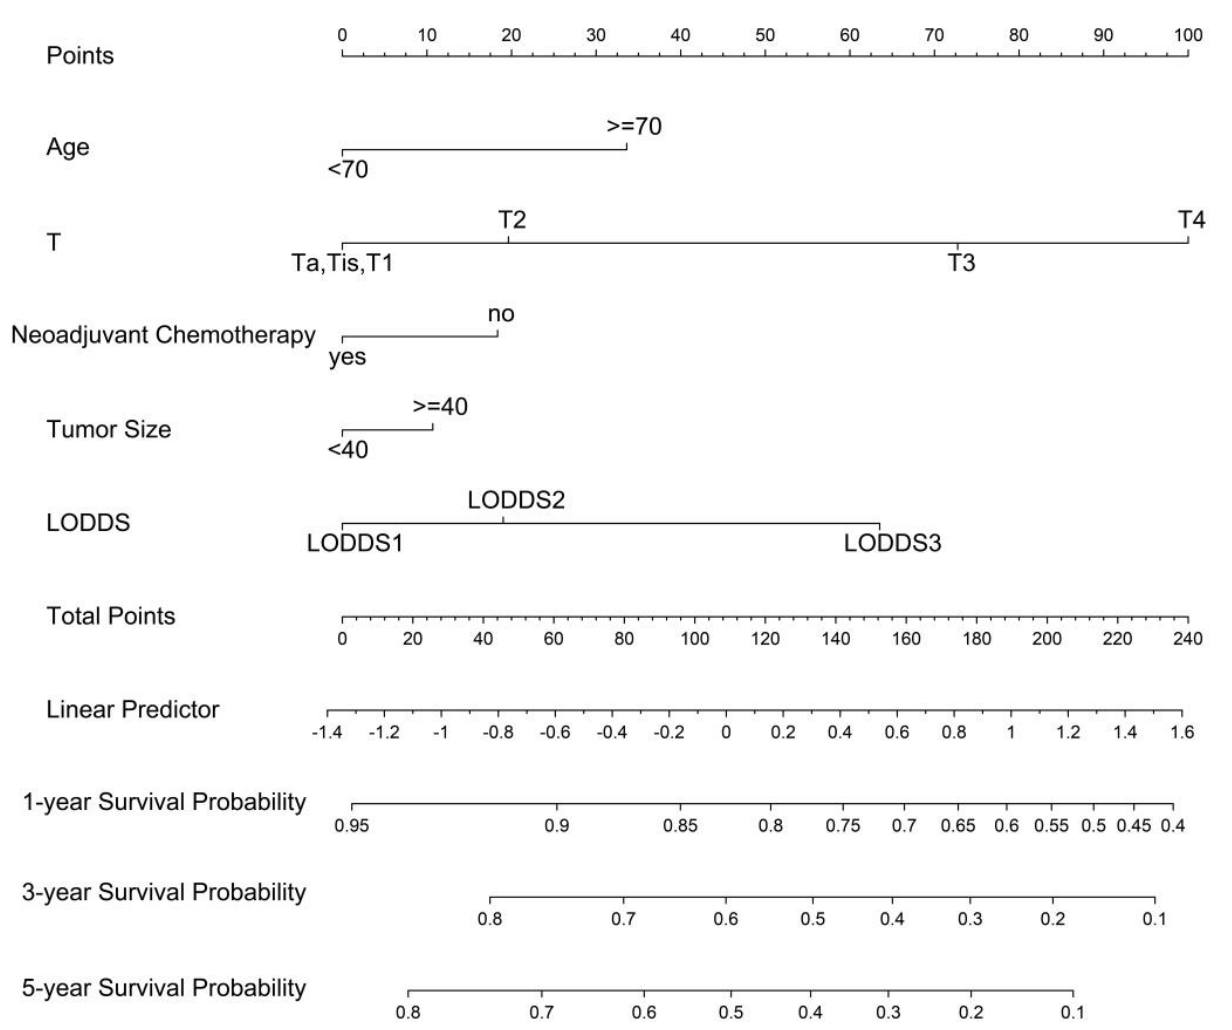
Figure 3. A nomogram to predict 1-, 3-, and 5- year overall survival for non-metastatic bladder cancer after surgical resection. LODDS: log odds of positive lymph nodes.